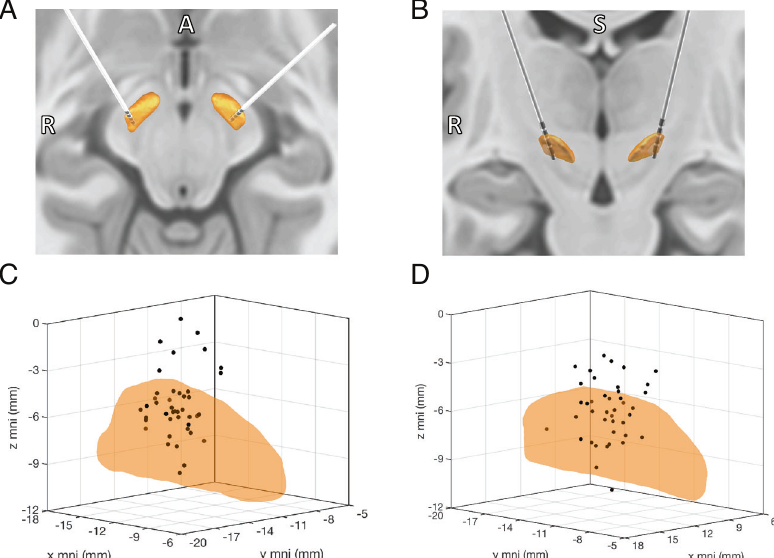
Fig. 1 Localization of active DBS contacts. Example localization of STN-DBS electrodes in NMI normalized brain space as viewed in axial ( A ) and coronal ( B ) projections. Locations of the active contact in MNI space for all patients ( N = 42) at the time of neuropsychological testing for the left ( C ) and right ( D ) STN.